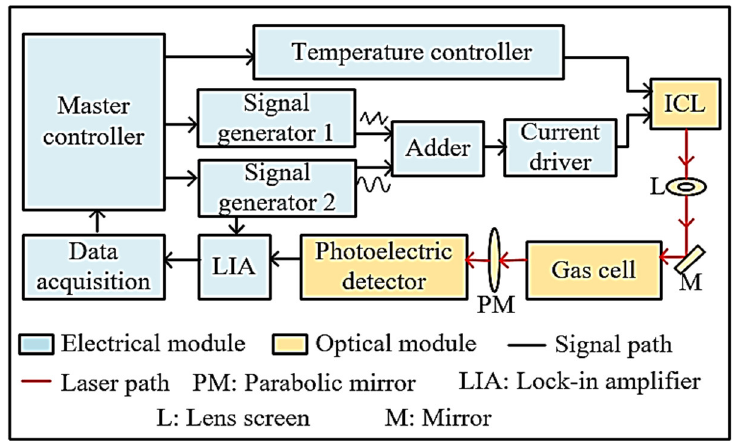
Figure 2. Schematic diagram of the C 2 H 2 detector.